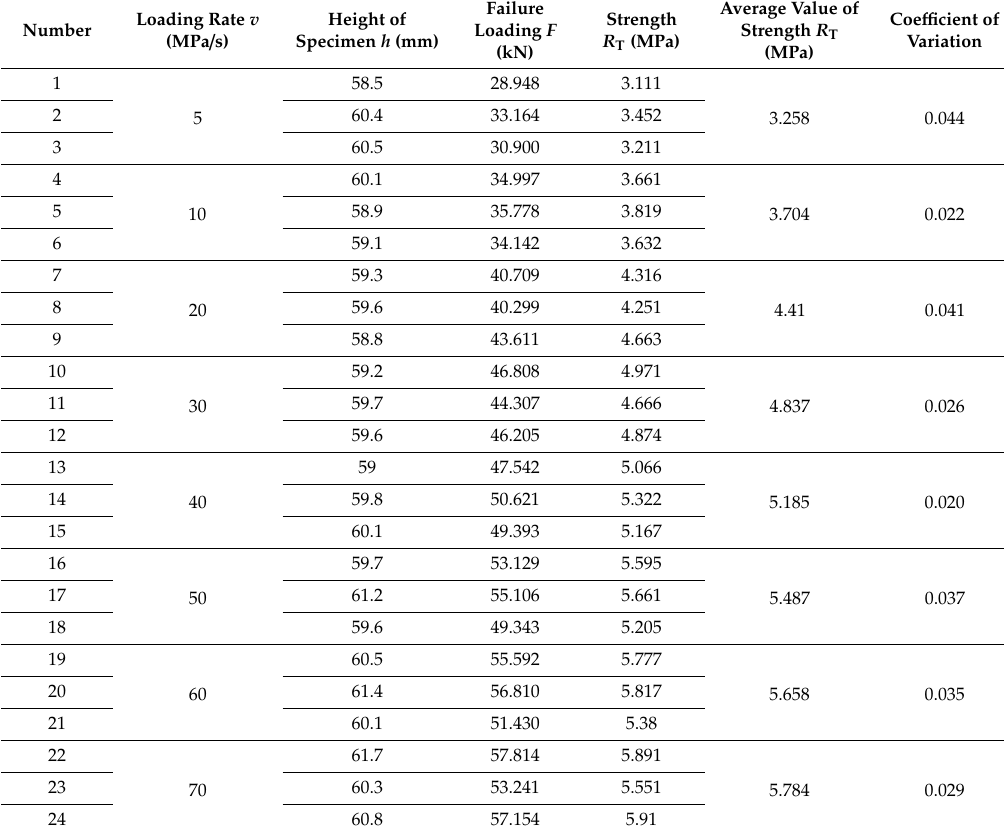
Table 6. Indirect tensile strength test of asphalt